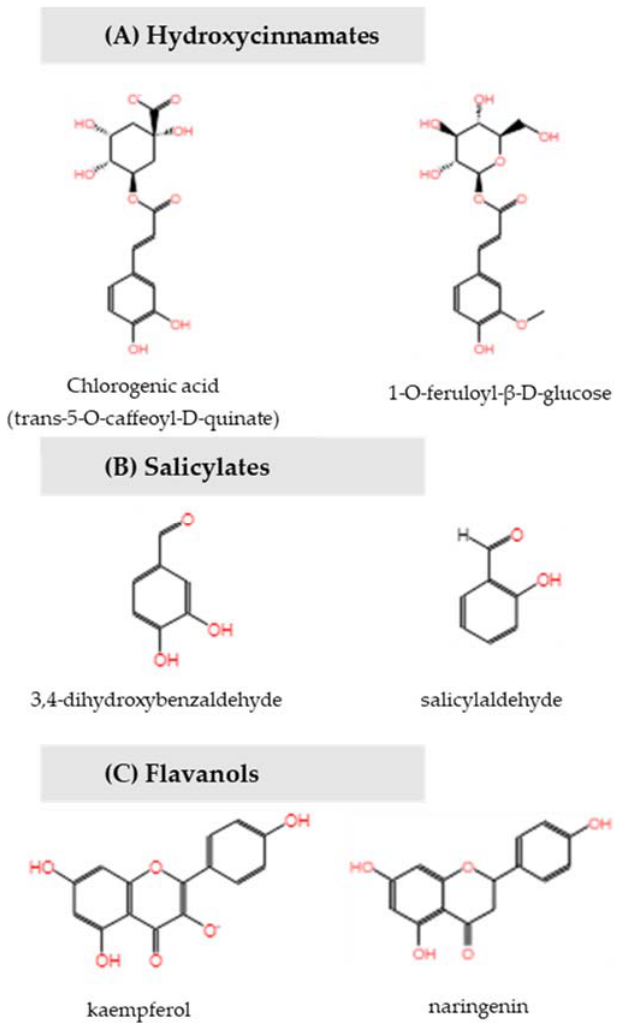
Figure 5. Compounds associated with the PAL (Phenylalanine Ammonia-Lyase) pathway to salicylic acid, including ( A ) hydroxycinnamates, ( B ) salicylates and ( C ) flavanols, show significant effects in ‘Nicoter’ and ‘Rosy Glow’ variable treatments associated with meristem bud formation.